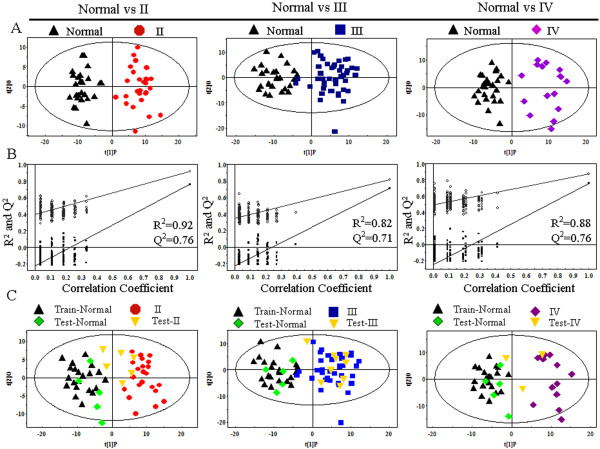
PR analysis of 1H-NMR spectra between different stages of esophageal cancer and normal mucosae. A, scores plot of OPLS-DA model processing based on each stage and normal mucosae, red dots represent stage II (n = 28); blue boxes represent stage III (n = 45); purple diamonds represent stage IV (n = 16) and black triangles represent normal mucosae (n = 26). B, statistical validation of the corresponding PLS-DA model by permutation analysis (200 times). R2 and Q2 represent the predictive ability to the model. C, scores plot of OPLS-DA prediction model. 80% of samples were applied to construct the model, and then used it to predict the remaining 20% of samples (normal mucosae = 5; stage II: n = 5; stage III: n = 9; stage IV: n = 3). Green diamonds represent normal mucosae and yellow inverted triangles represent esophageal cancers.